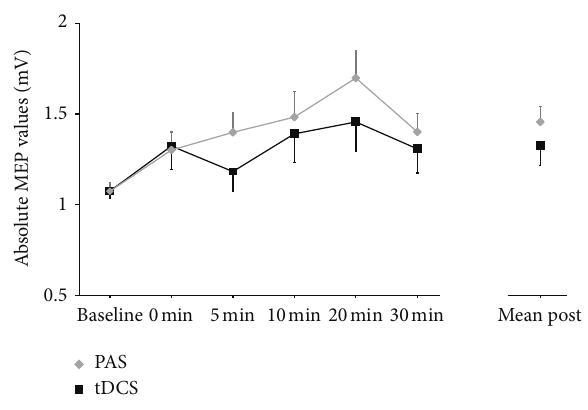
Figure 2: MEP values at baseline and all time points following anodal tDCS and PAS. MEP values are shown as untransformed values and scaled in mV and error bars representing the standard error of the